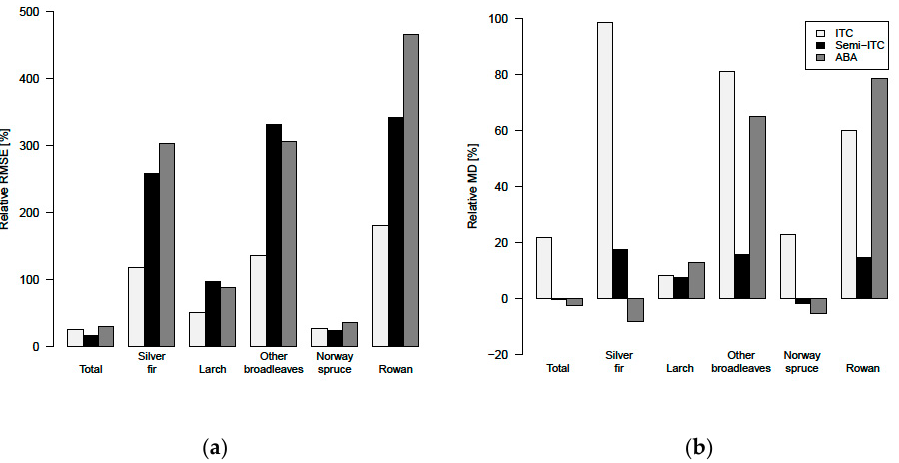
Figure 6. ( a ) Relative RMSEs and ( b ) relative MDs of the total and five species classes’ volumes obtained by the three inventory approaches: ITC, semi-ITC, and